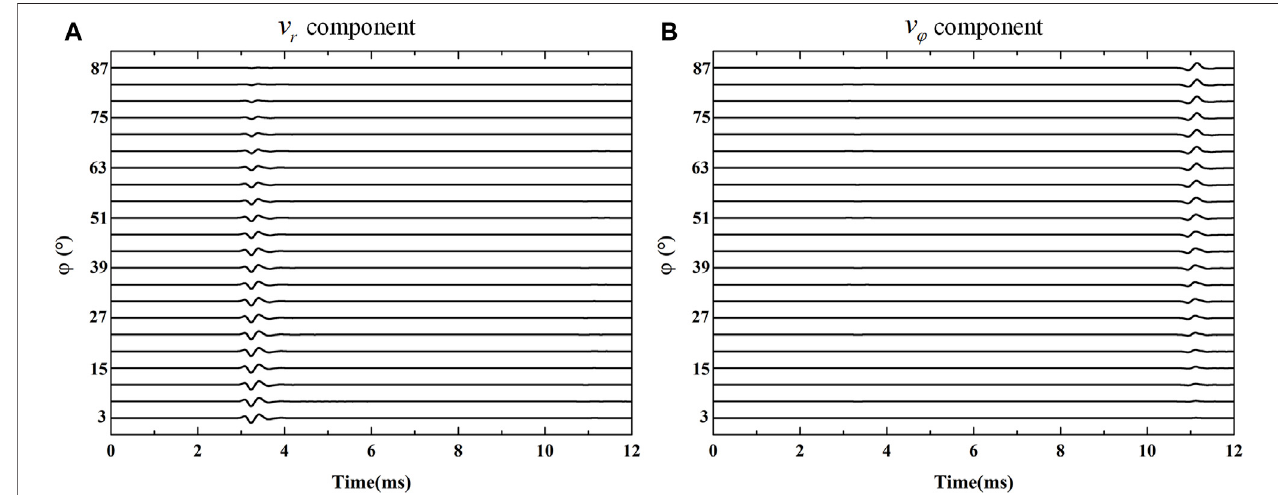
FIGURE 7 | The waveforms of (A) P-wave and (B) SH-wave received on the red circle (see Figure 6 ).